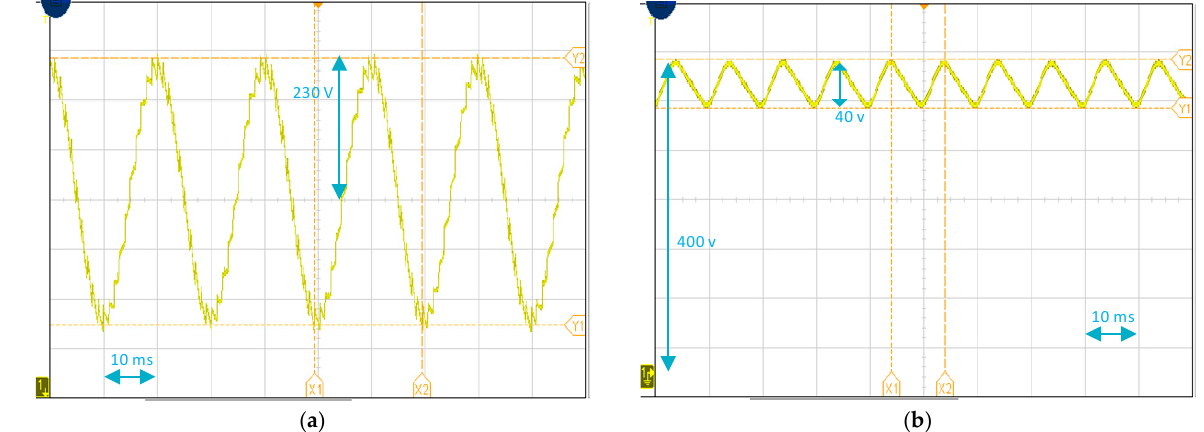
Figure 8. Experimental results. ( a ) Input voltage, v g , and ( b ) output voltage, v o .